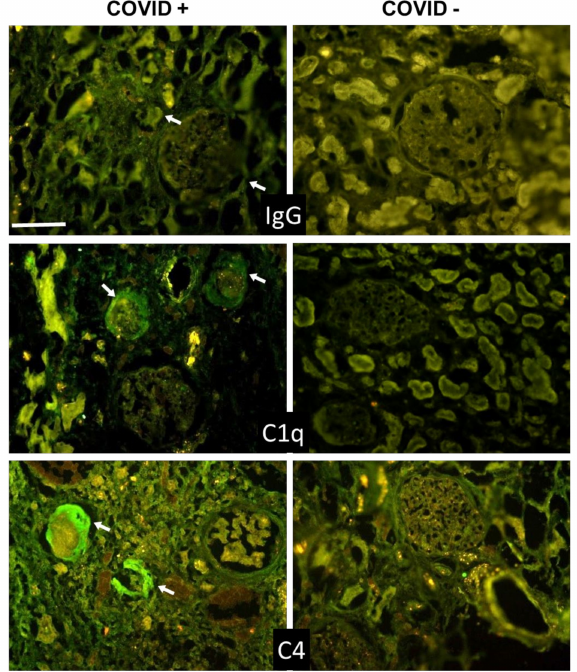
Figure 3. Detection of IgG, C1q, and C4 in kidney sections by immunofluorescence analysis. The panel shows representative immunofluorescence images obtained from the analysis of several sec- tions of kidney autopsy samples from 12 SARS-CoV-2-positive and 3 negative cases. See legend to Figure 1 for further details. White arrows show IgG, C1q, and C4 periglomerular deposition. Scale bar = 50 µ m.